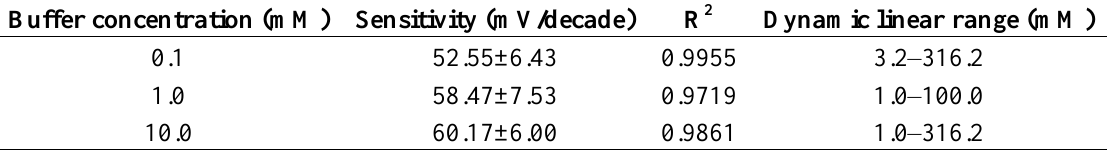
Table 1. AOX-poly(nBA-NAS) microspheres based biosensor responses towards different concentrations of formaldehyde in Tris-HCl buffer pH 6.5.